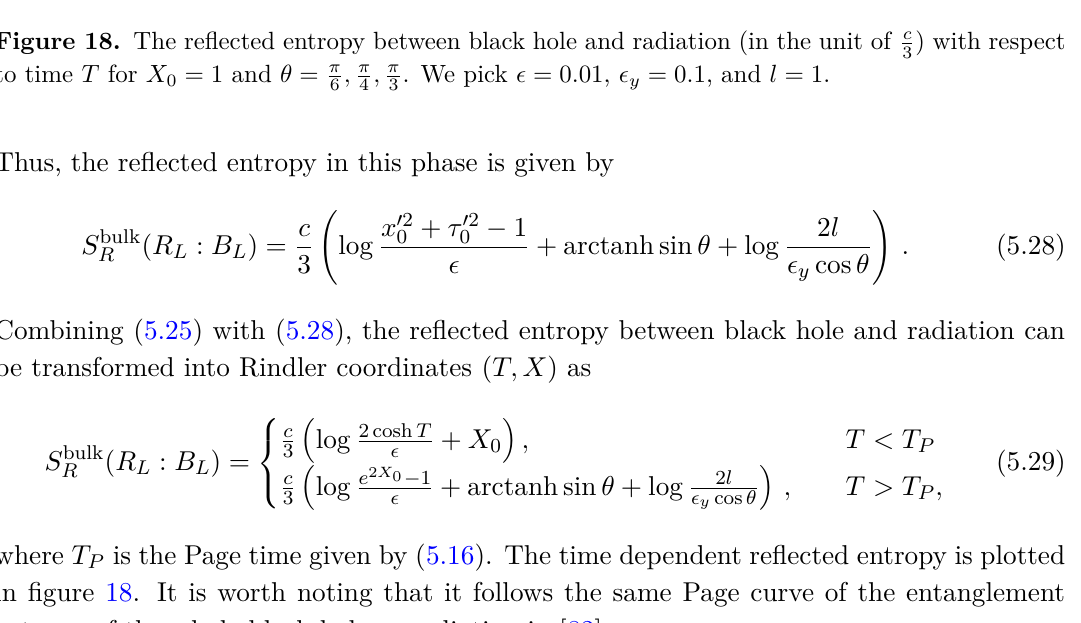
, π , π . We pick (cid:15) = 0 . 01 , (cid:15) y = 0 . 1 , and l = 1 6 4 3